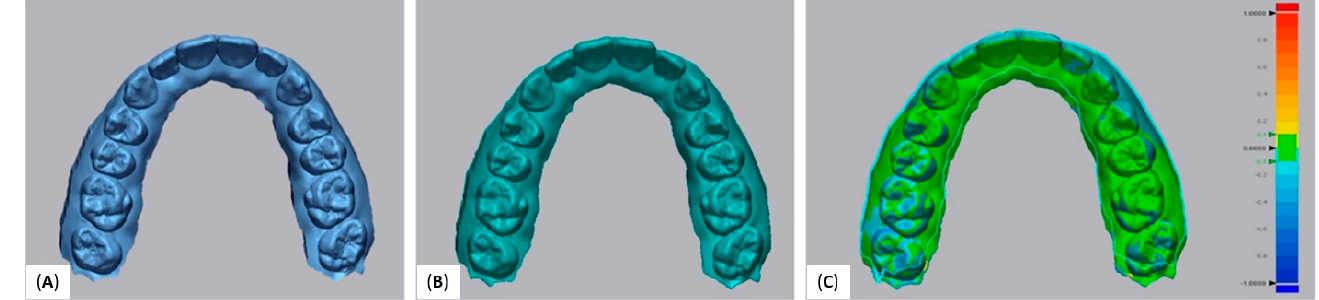
Figure 2. ( A ) Reference STL file, ( B ) STL file resulted from the 3D printed model, ( C ) 3D comparison of the two STL files.